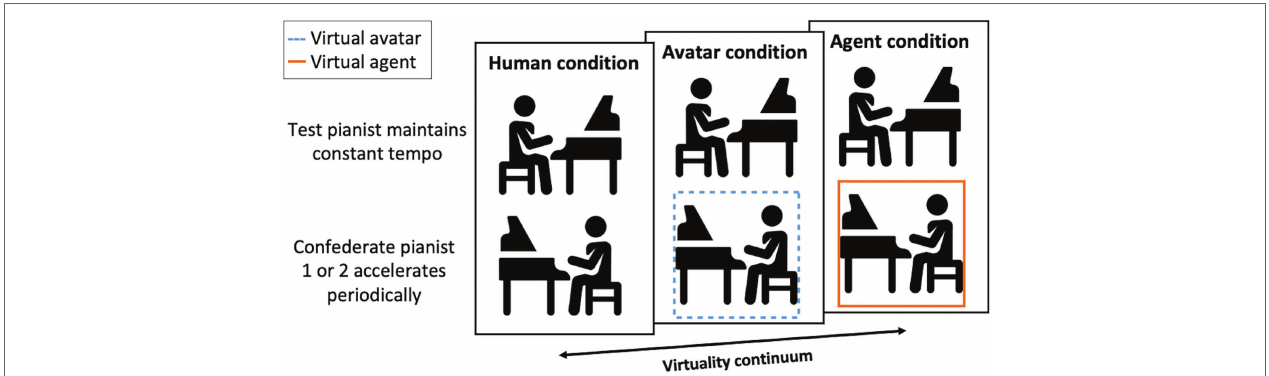
FIGURE 2 | Conditions in the case-study (Confederate pianist 1 plays in the Human and Avatar condition, a recording of Confederate pianist 2 plays in the Agent